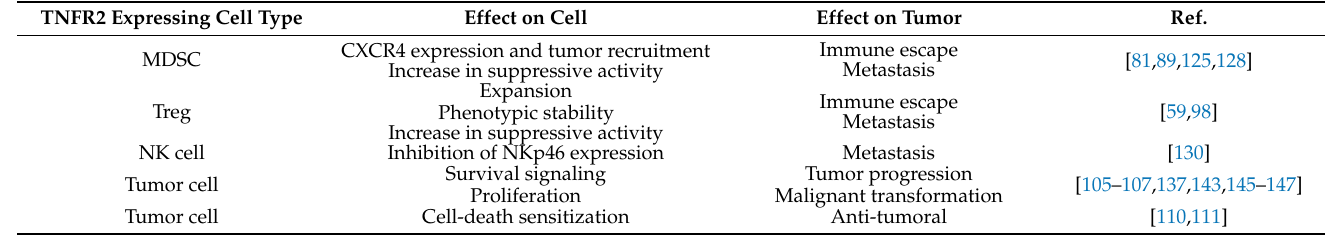
Table 1. Tumor-related functions/activities of